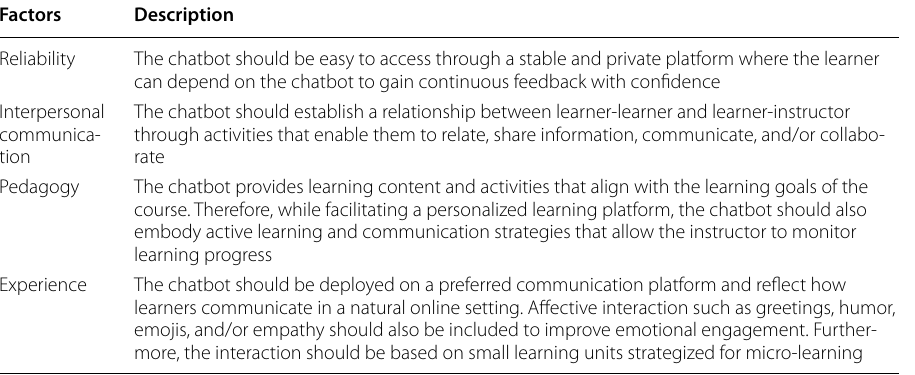
Table 3 Describing RiPE for educational chatbots